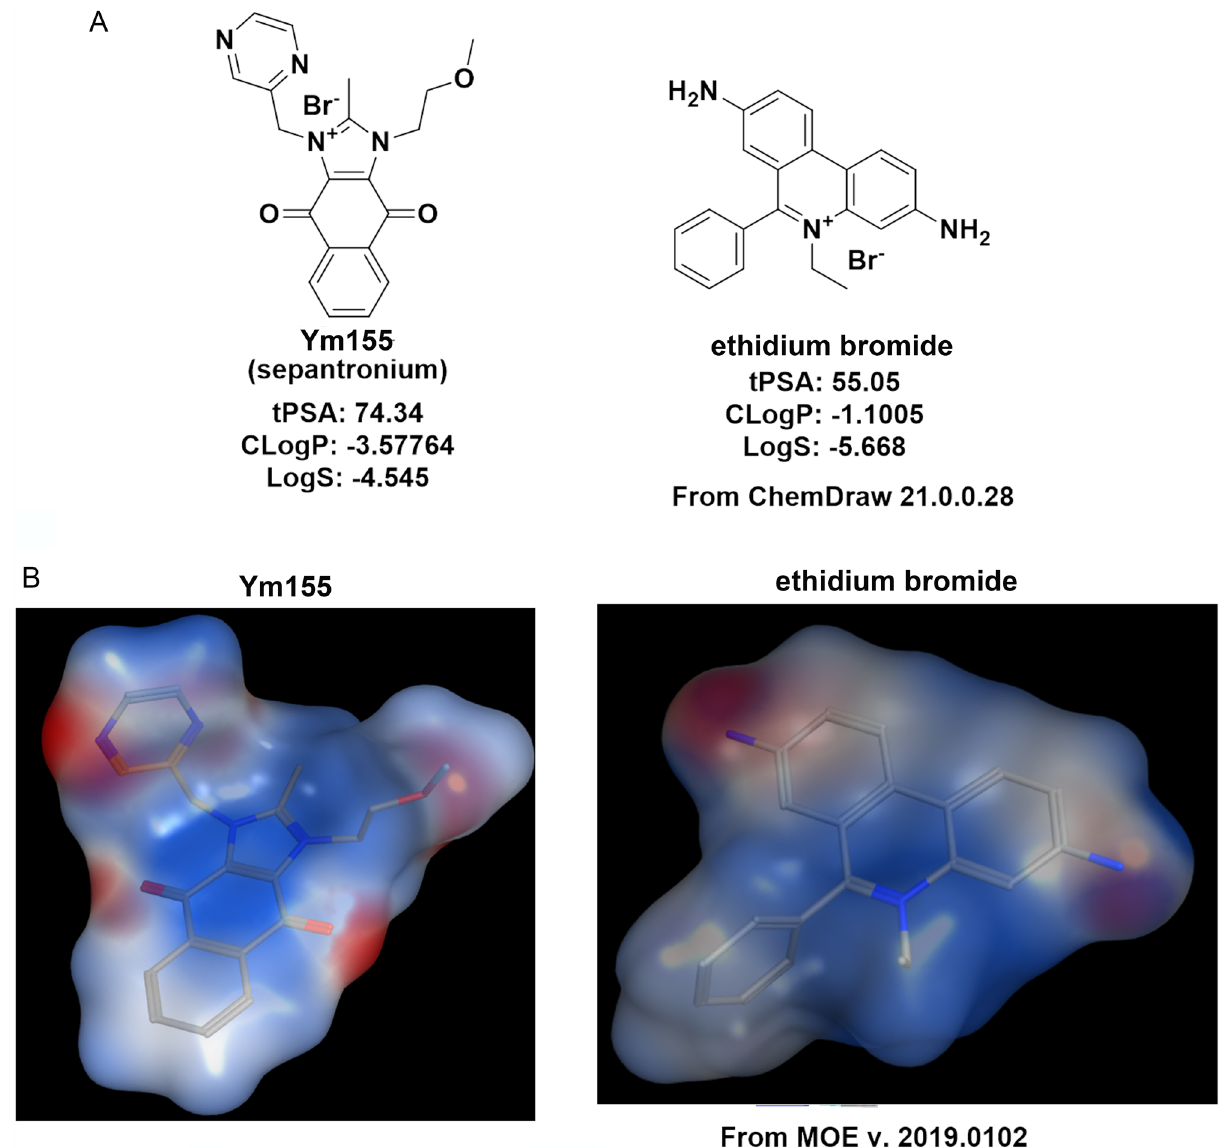
Figure 1. Structural properties of Ym155 are similar to Ethidium Bromide: ( A ) Structures of Ym155 and ethidium bromide with calculated topological polar surface area (tPSA), octanol–water partition coefficient (CLogP), and LogS. ( B ) Similarities of the electrostatic charge distributions of Ym155 and ethidium bromide determined with Molecular Operating Environment (MOE)